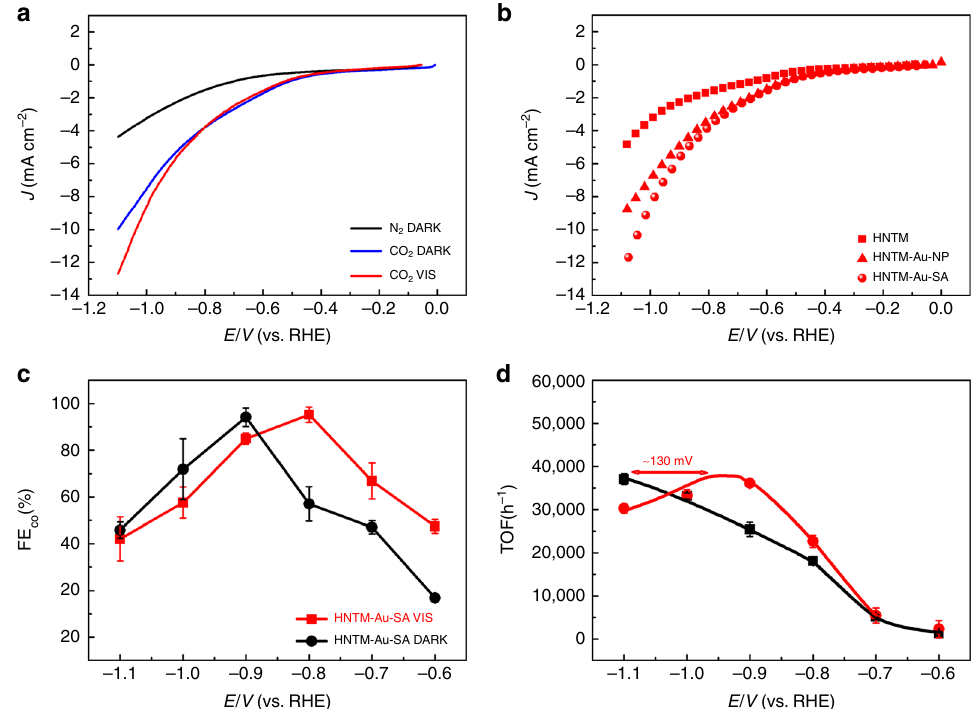
Fig. 3 Photo-coupled electrochemical and electrochemical performance of CO 2 reduction. a LSV curves of HNTM-Au-SA scanned at 5 mv s − 1 in N 2 - saturated (black line) and CO 2 -saturated 0.1 M KHCO 3 under visible light (red line)/dark (blue line). b LSV curves of HNTM, HNTM-Au-SA, and HNTM- Au-NP in CO 2 -saturated 0.1 M KHCO 3 under visible light. c FE CO on HNTM-Au-SA at the potentials of − 0.6 V to − 1.1 V under visible light (red line)/dark (black line). d TOF curves of HNTM-Au-SA under visible light (red line)/dark (black line). Error bars are ±